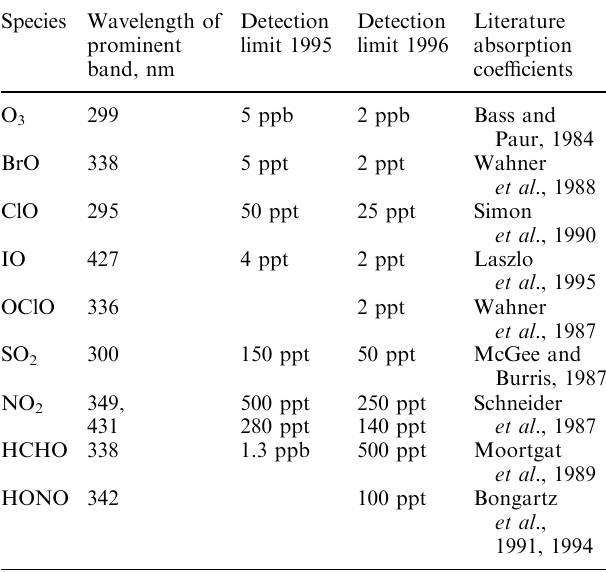
Detection Detection Literature limit 1995 limit 1996